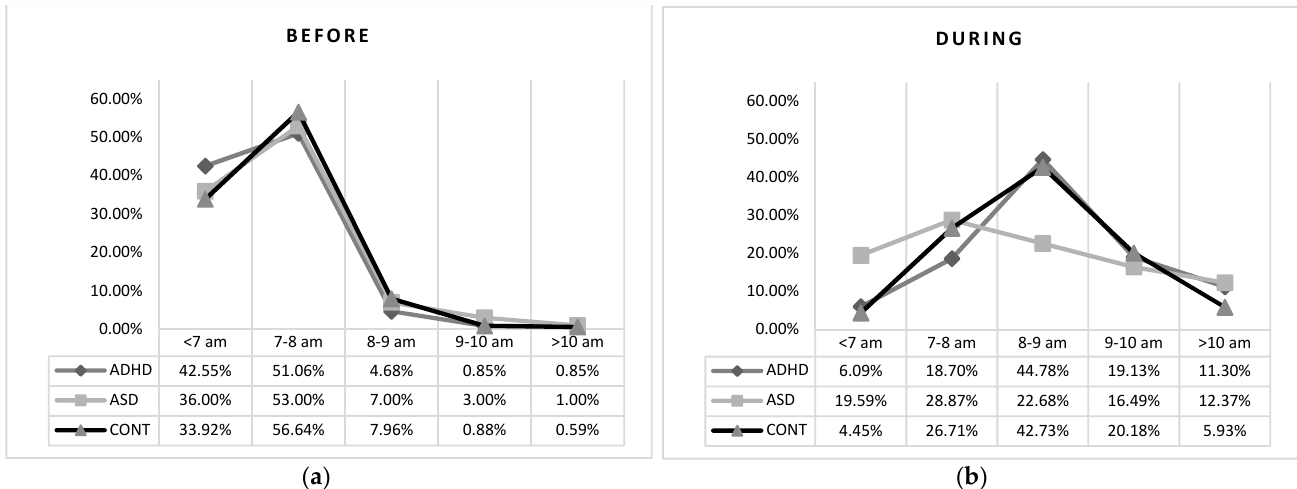
Figure 2. Risetime before ( a ) and during ( b ) lockdown in the tree groups.